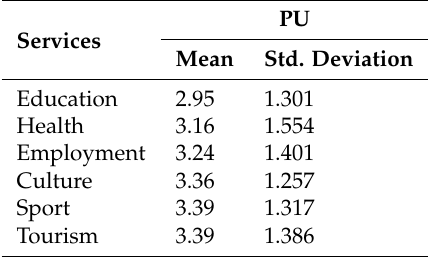
Table A12. Ranking of information sectors by mean score of PEOU.